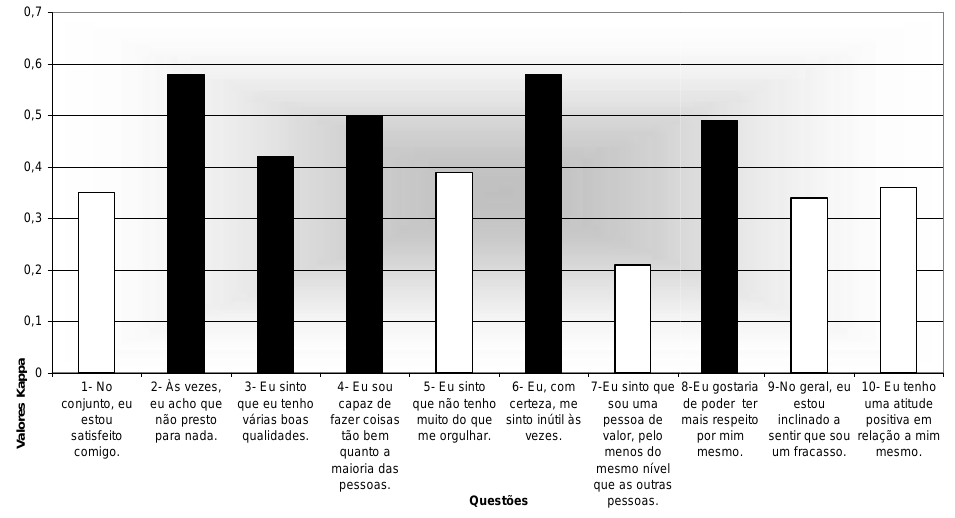
Figura 1. Grau de Concordância da Escala de Auto-Estima de Rosenberg segundo o Kappa Ponderado. Notas .